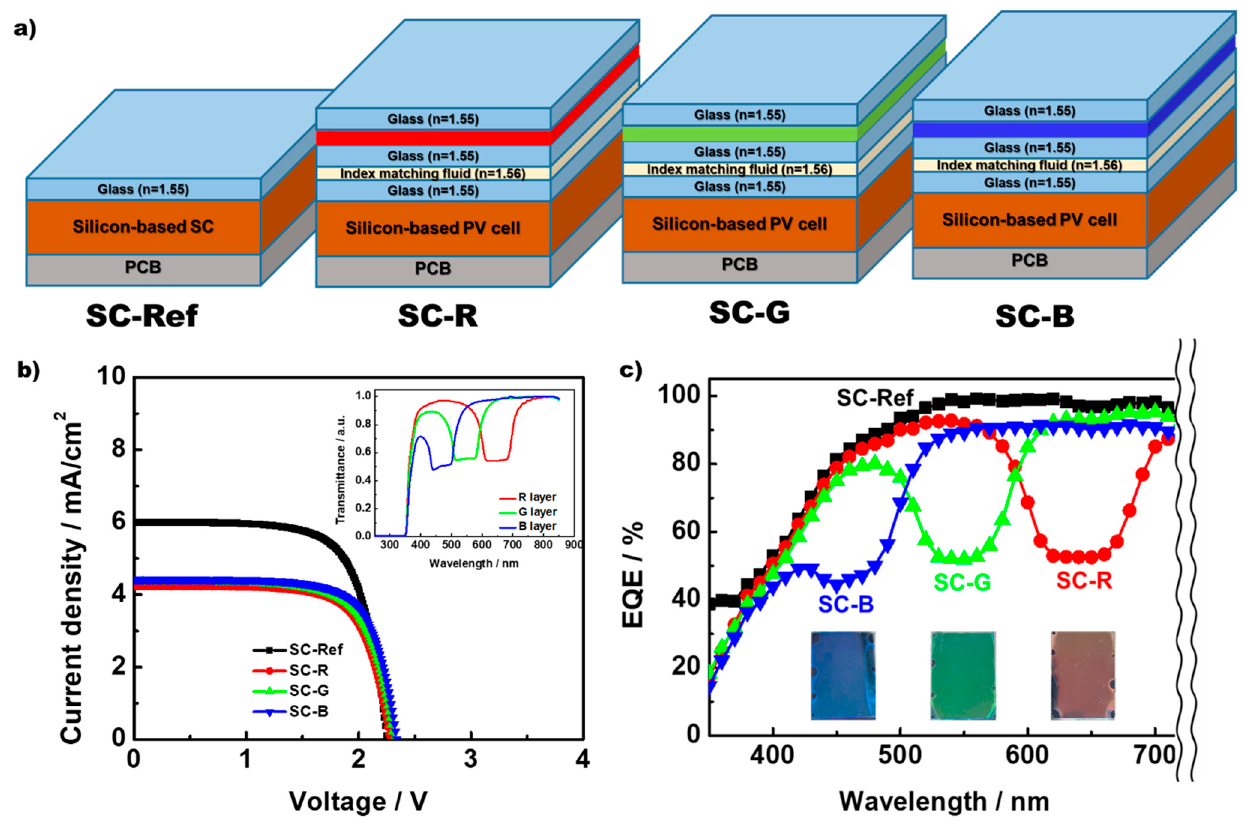
Figure 4. ( a ) Schematic illustrations of the four modules investigated in this study. ( b ) Typical current–voltage (J–V) curves of the four modules. Transmittance curves of the fabricated R, G, and B Ch layers are depicted in the inset. ( c ) EQE spectra of the fabricated R, G, and B Ch layers. Photos of the SC-R, SC-G, and SC-B modules are presented in the inset. The EQE spectra were evaluated using the QE measurement system (Newport), which records J SC by applying a monochromatic light on the samples under ambient conditions.